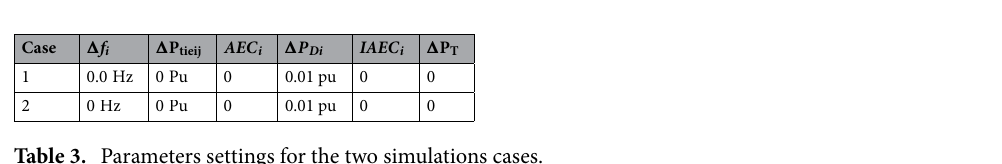
Table 3. Parameters settings for the two simulations